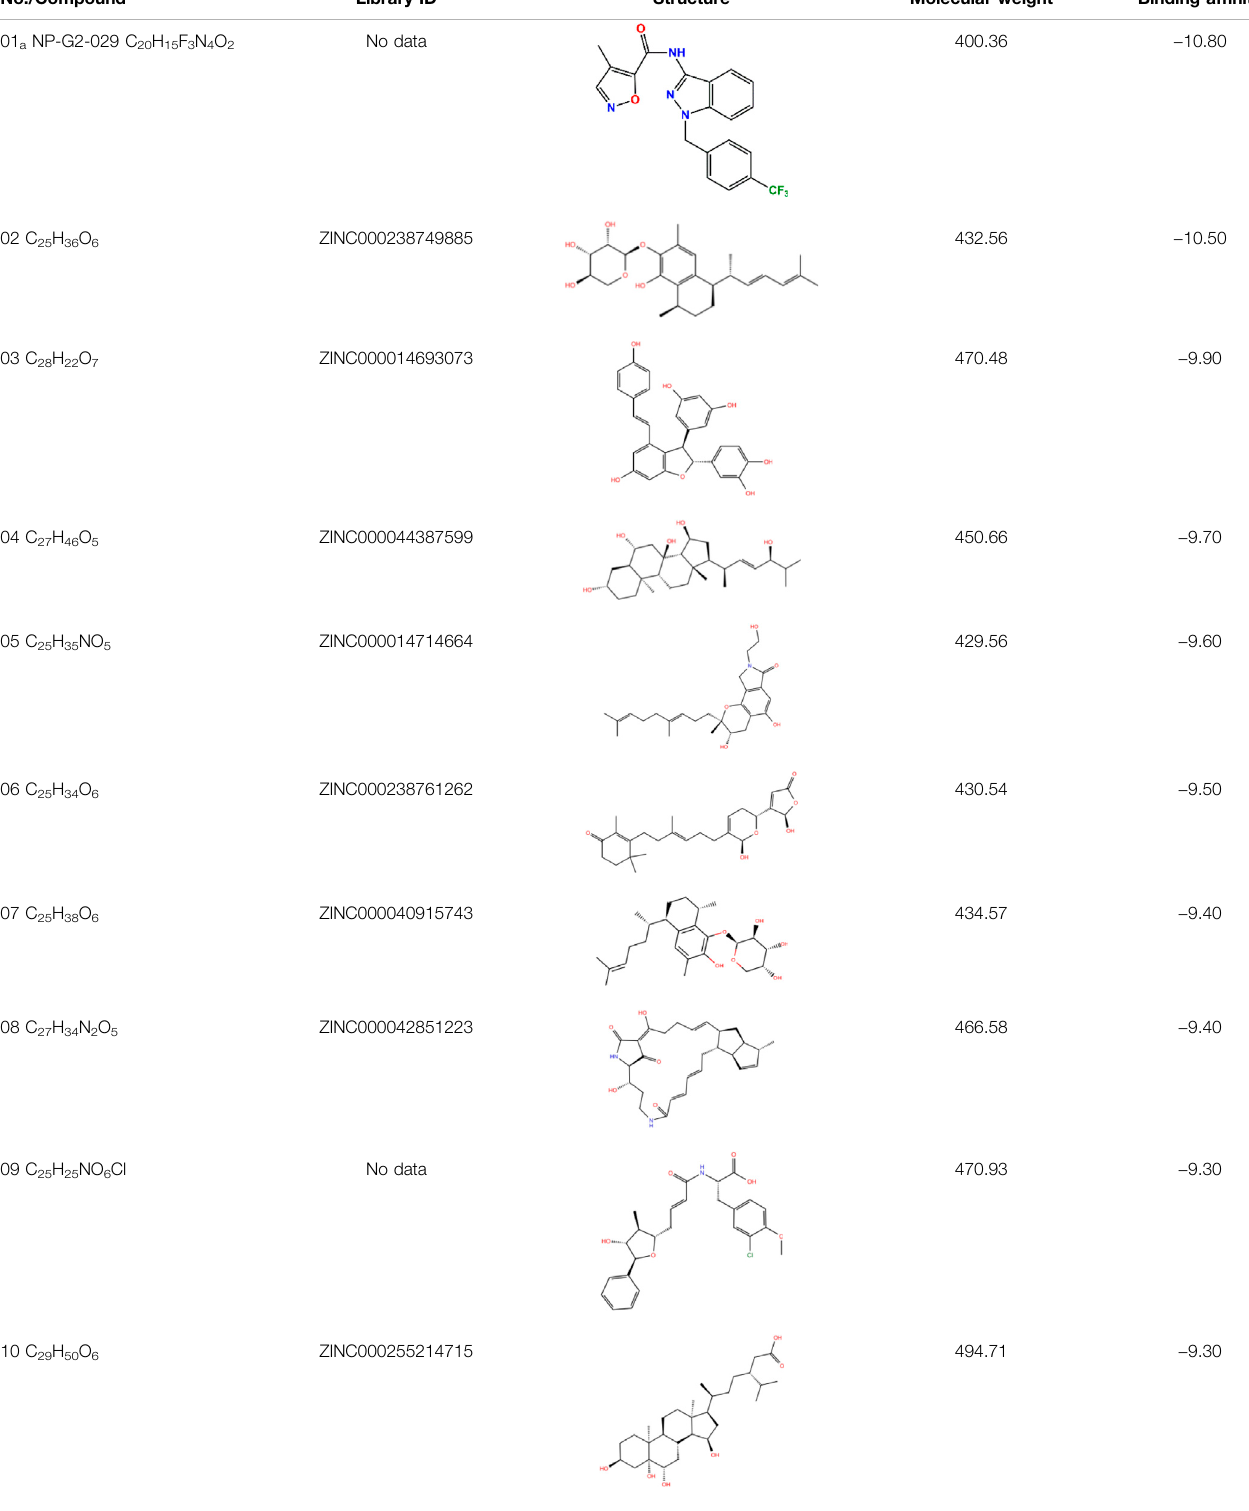
TABLE 1 | Data collection of potential inhibitors for Fascin by molecular docking. Unit: